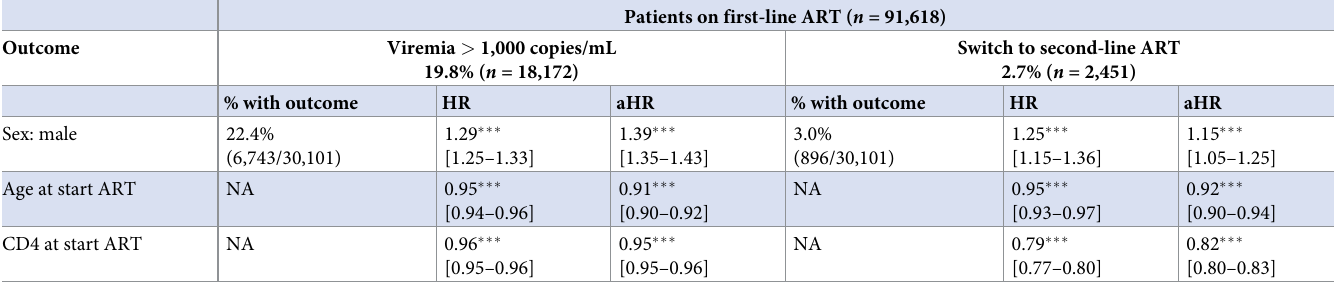
Table 2. Mixed-effects Cox proportional hazards analysis—Viremia and switch to second-line ART.